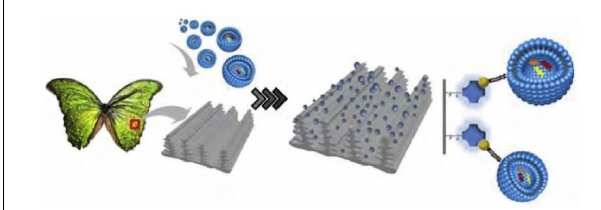
FIGURE 3 | Scheme of isolation and enrichment of EVs by M. Menelaus wings. M. Menelaus wings were modified by lipid nanoprobes. When samples through M. Menelaus wings, the lipid nanoprobes can insert into the EV membranes to capture